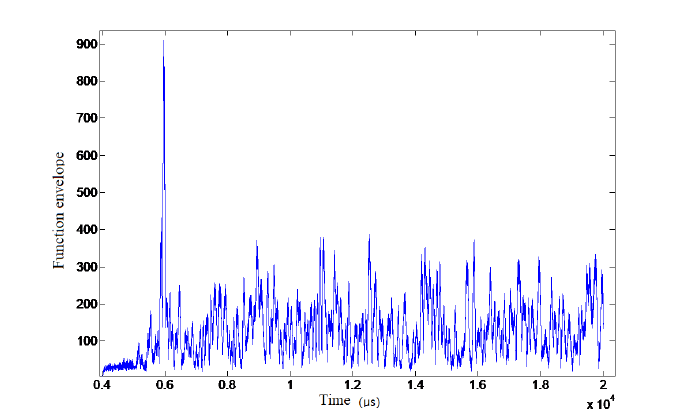
Figure 8. The correlation function envelope in test